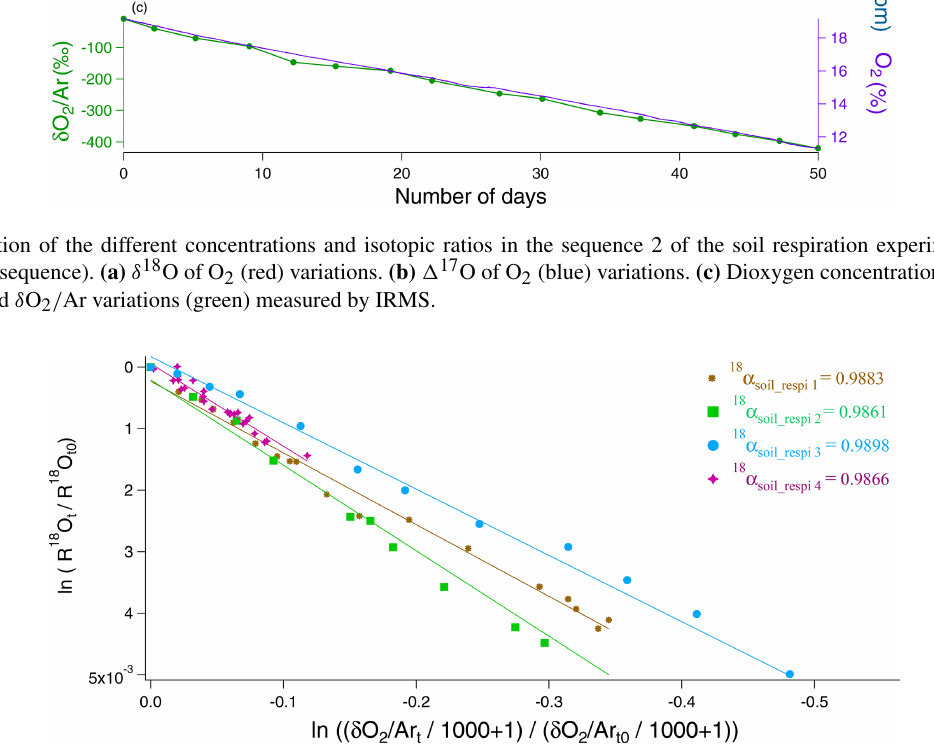
sequence: (cid:104) F total_respi (cid:105) and (cid:104) 18 α total_respi (cid:105) . We also